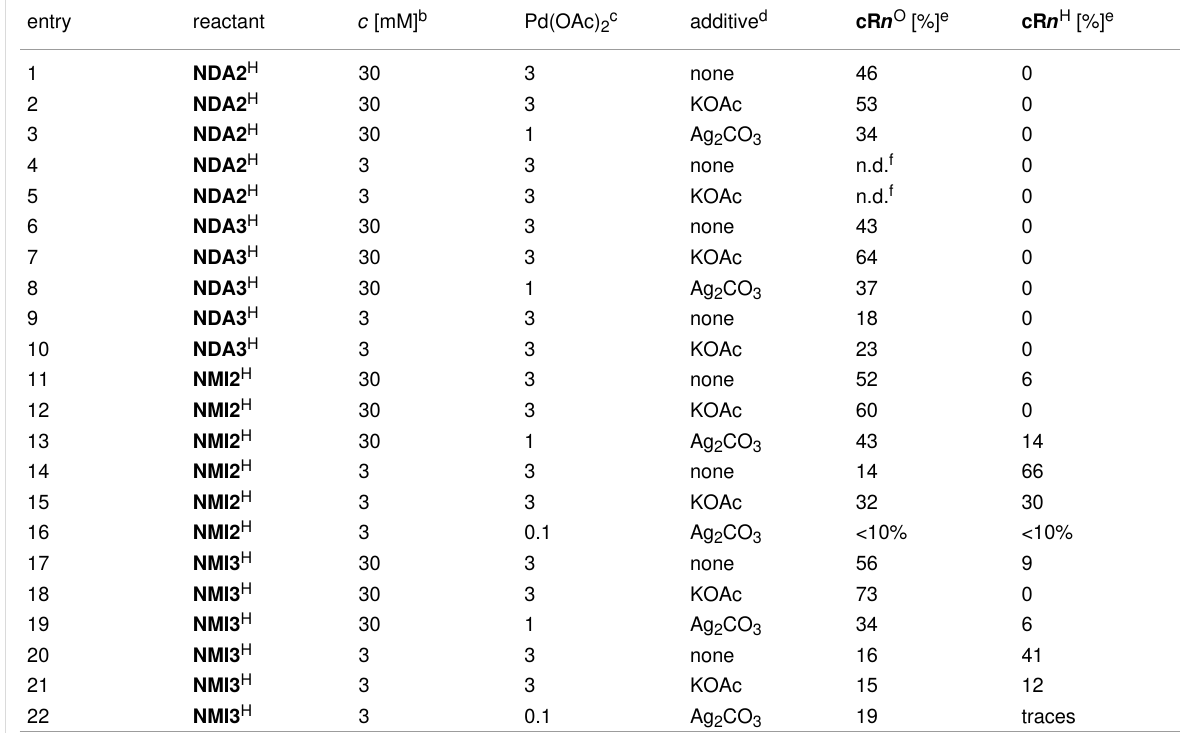
Table 1: Screening of reaction conditions.